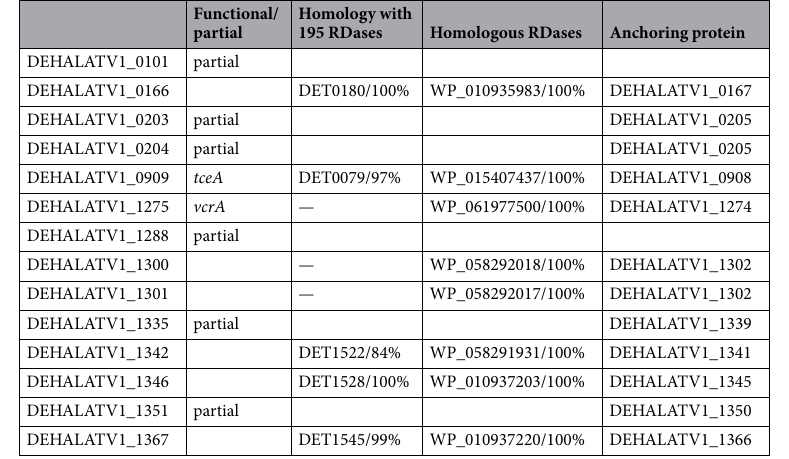
Table 3. Reductive dehalogenase genes in the genome of D. mccartyi